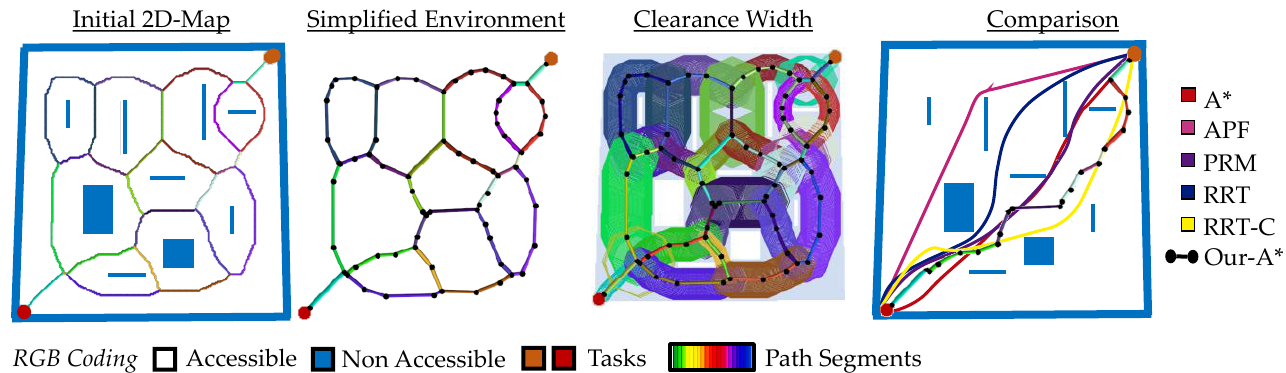
Figure 25. Comparison of the simplification and path suggestion considering the use-case of [24] with alternative path finding algorithm.